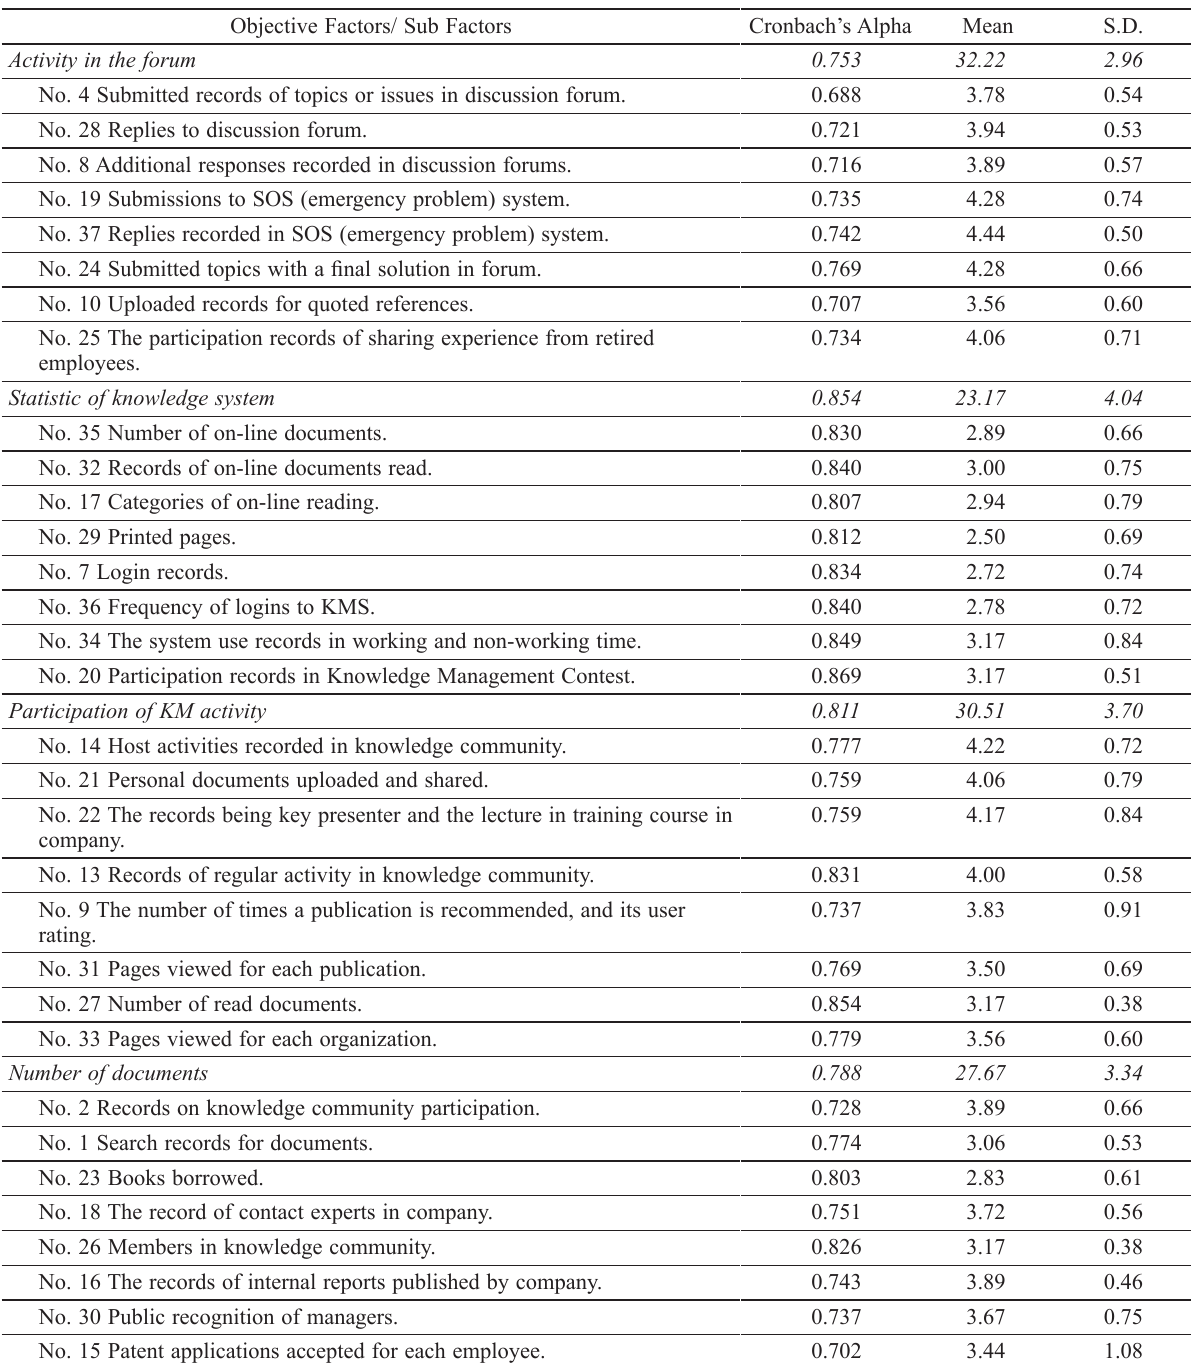
Table 8. Reliability and average score of various factors in the scale Objective Factors/ Sub Factors Activity in the